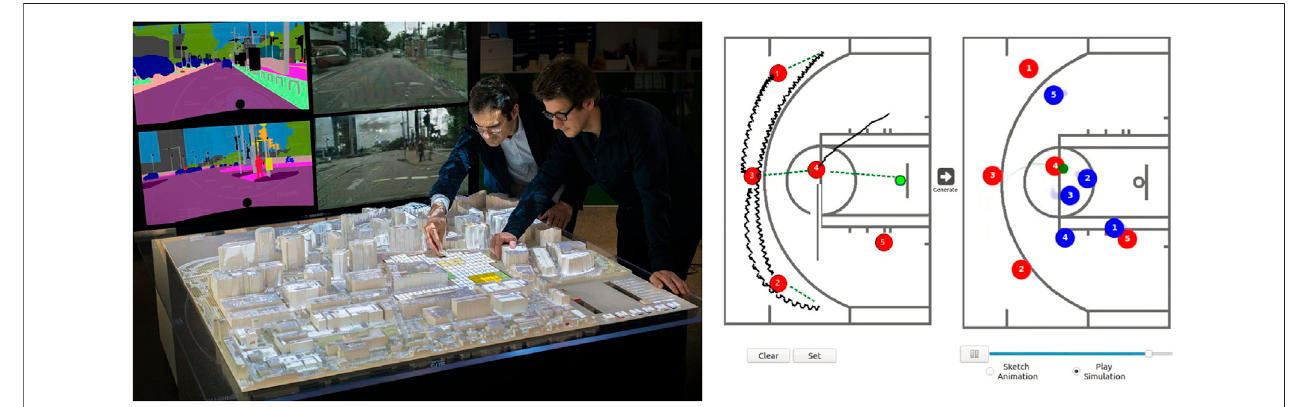
FIGURE 7 | Left: The TUI interface for the DeepScope system. Here, the designers move about physical objects representing urban tile classes and can view the cityscape emerge in real time. Right: The user interface for BasketballGAN looks much like a traditional basketball clipboard sheet.